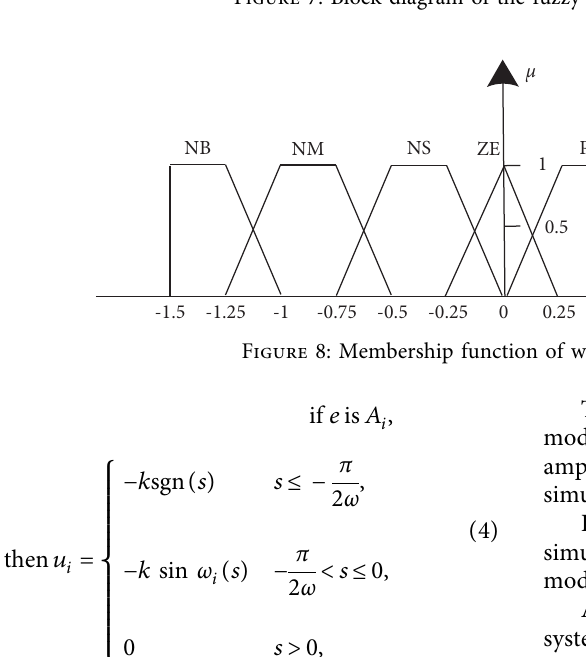
Figure 7: Block diagram of the fuzzy sliding mode controller.